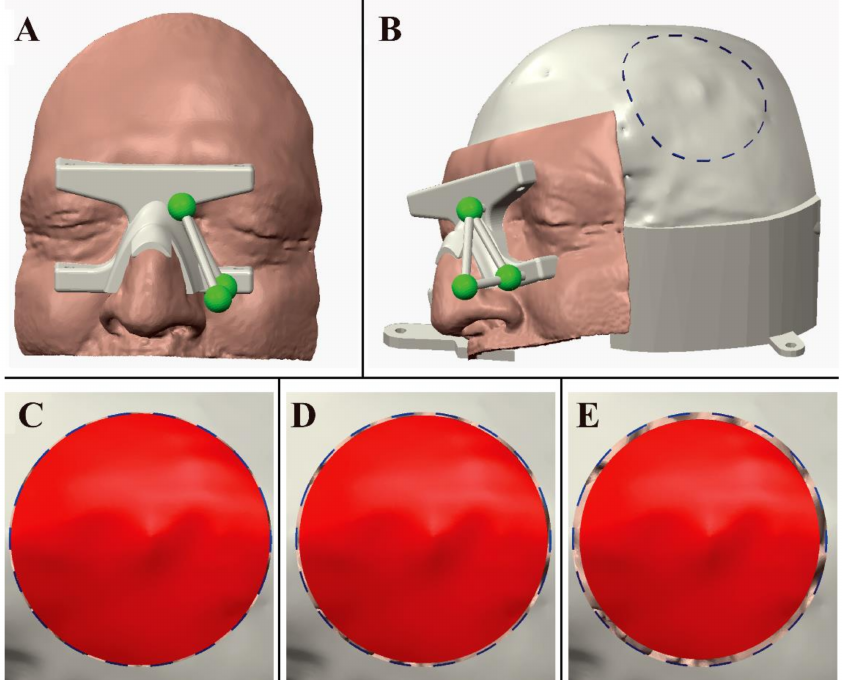
Figure 4. ( A ) Design of the patient-specific registration template and of the manikin’s head. ( B ) De- sign of the manikin’s head with planned circular craniotomy trajectory. ( C – E ) Shows three bone flaps with a gap that decreases 0.5 mm ( C ), 1 mm ( D ), 2 mm ( E ) from the ideal